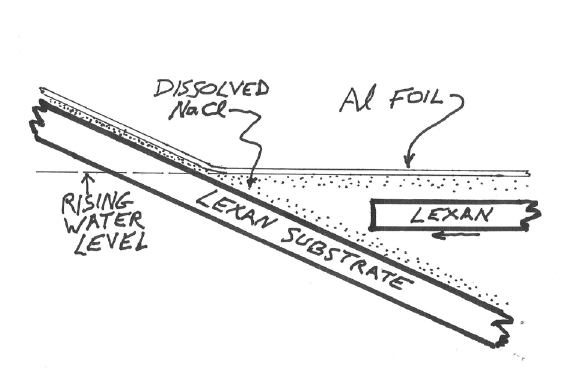
Fig. 8 : “Barrier” Lexan sheet placed to prevent large convection cells from reaching the floating foil.